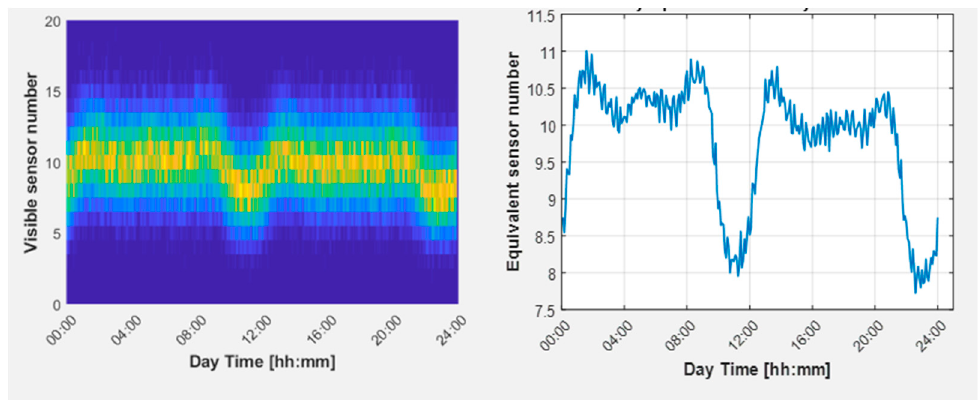
Figure 5. Estimation of the probability density of LEO-SAR visibility in GEO-SAR: Earth view ( left ) and mean number of satellites, ( right ), as function of time, derived from analysis of Table 1.